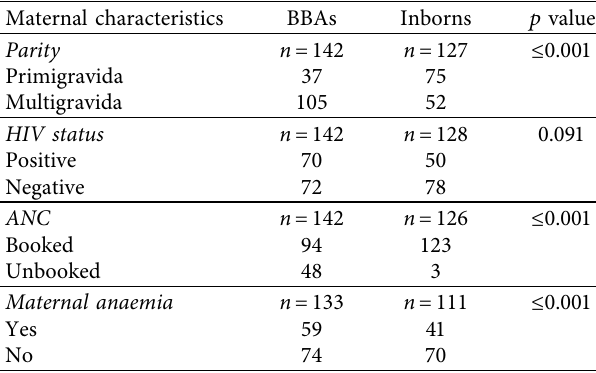
Table 1: Maternal